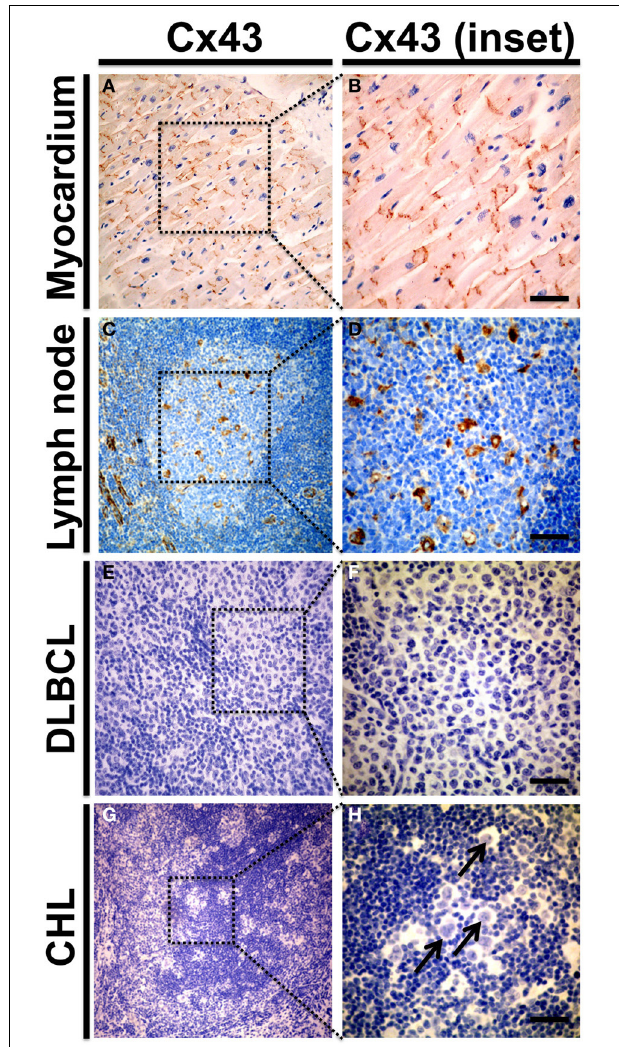
FIGURE 3 | Cx43 protein expression in human reactive lymph nodes and lymphomas. Representative microphotographs from formalin fixed paraffin embedded samples of morphologically normal human myocardium ( n = 3, A,B) , reactive lymph node with follicular and parafollicular hyperplasia ( n = 4, C,D), diffuse large B cell lymphomas ( n = 13 DLBCL, E,F) and classical Hodgkin’s lymphoma ( n = 9 CHL, G,H) . Samples were included in a tissue microarray and stained with chromogenic immunohistochemical method for Cx43 using a mouse monoclonal antibody at 1:100 dilution (Zymed Laboratories). Preparations were counterstained with hematoxylin to visualize nuclei. Right panels (B,D,F,H) show magnified insets from low power images on the left (A,C,E,G) . (A,B) Depicts control Cx43 distribution in intercalated discs of human myocardiocytes. In non-tumor lymph nodes (C,D) Cx43 staining was predominantly detected in endothelial cells; and in cells with morphological features more consistent with macrophages and follicular dendritic cells. Cx43 was not detected in DLBCL and CHL samples (E–H) . Arrow in (H) indicates Hodgkin/Reed-Stemberg cells. Bar = 50 μ